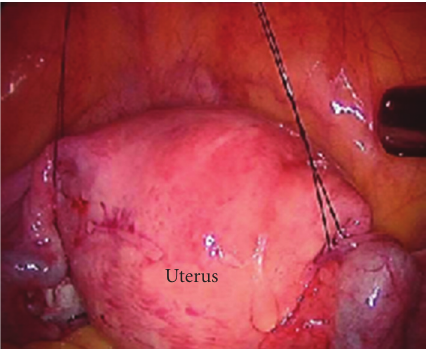
Figure 2: Monofilament polyamide suture on needle is used for hitching the uterus. The suture is passed through the uterine fundus anteroposteriorly and brought out to the exterior through the anterior abdominal wall.